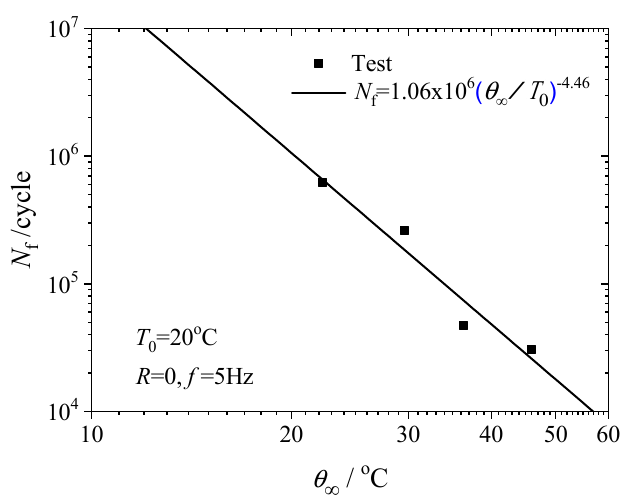
Figure 10. Fatigue lives vs. steady state temperature increases.